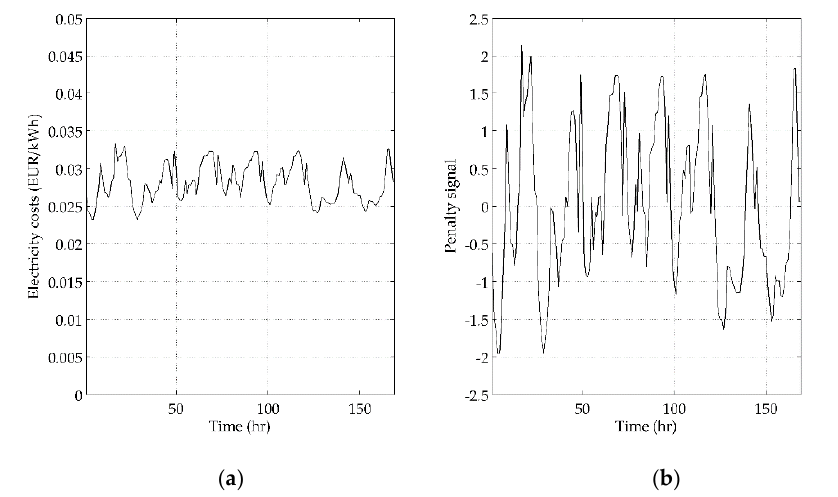
Figure 8. Electricity cost signal for the selected summer week: ( a ) hourly energy cost, c ; ( b ): penalty signal, p .